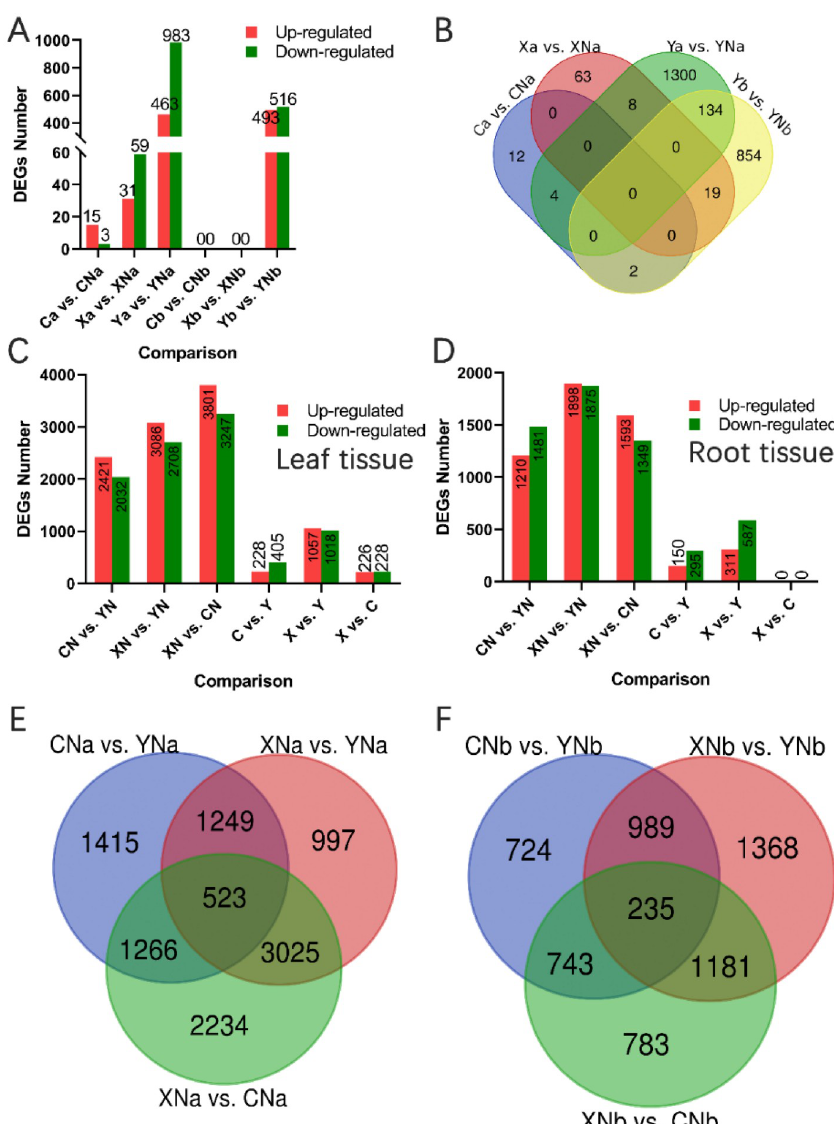
Fig 4. Differentially expressed genes (DEGs) between different treatments. A, the number of DEGs in the leaf (a for short) and root (b for short) induced by N deficiency. B, the Venn diagram of the DEGs in the leaf of potato in response to N deficiency. C and D, the statistics and Venn diagram of the DEGs in leaves of potato, respectively. E and F, the statistics and Venn diagram of the DEGs in root of potato, respectively. The red bar indicates up-regulated genes; green bar indicates down-regulated genes. A and b are short for leaf and root, respectively. Y, X and C indicate the cultivar of “Yanshu 4”, “Xiabodi” and “Chunshu 4”, respectively. N means treatment with N containing fertilizer (control). For example, YN and Y means “Yanshu 4” treated with N-containing and N-deficiency fertilizer, respectively. both the leaf and root tissues (Fig 6). In addition, many major facilitator superfamily (MFS) members were clustered, which showed different expression patterns between root and leaf in Y (Fig 6). Among these MFS members, there were several high affinity StNRTs , including StNRT2 . 4 , StNRT2 . 5 and StNRT2 . 7 (Fig 6). These multiple expression profiles of MFS mem- bers suggested the nonredundant functions in potato leaf and root. However, the number of